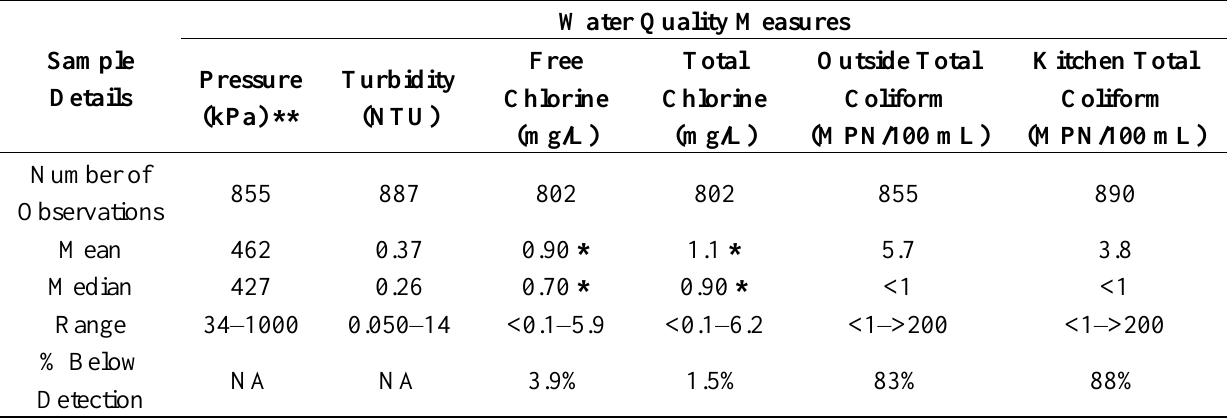
Table 2. Summary of drinking water quality measures for households using small rural drinking water systems in